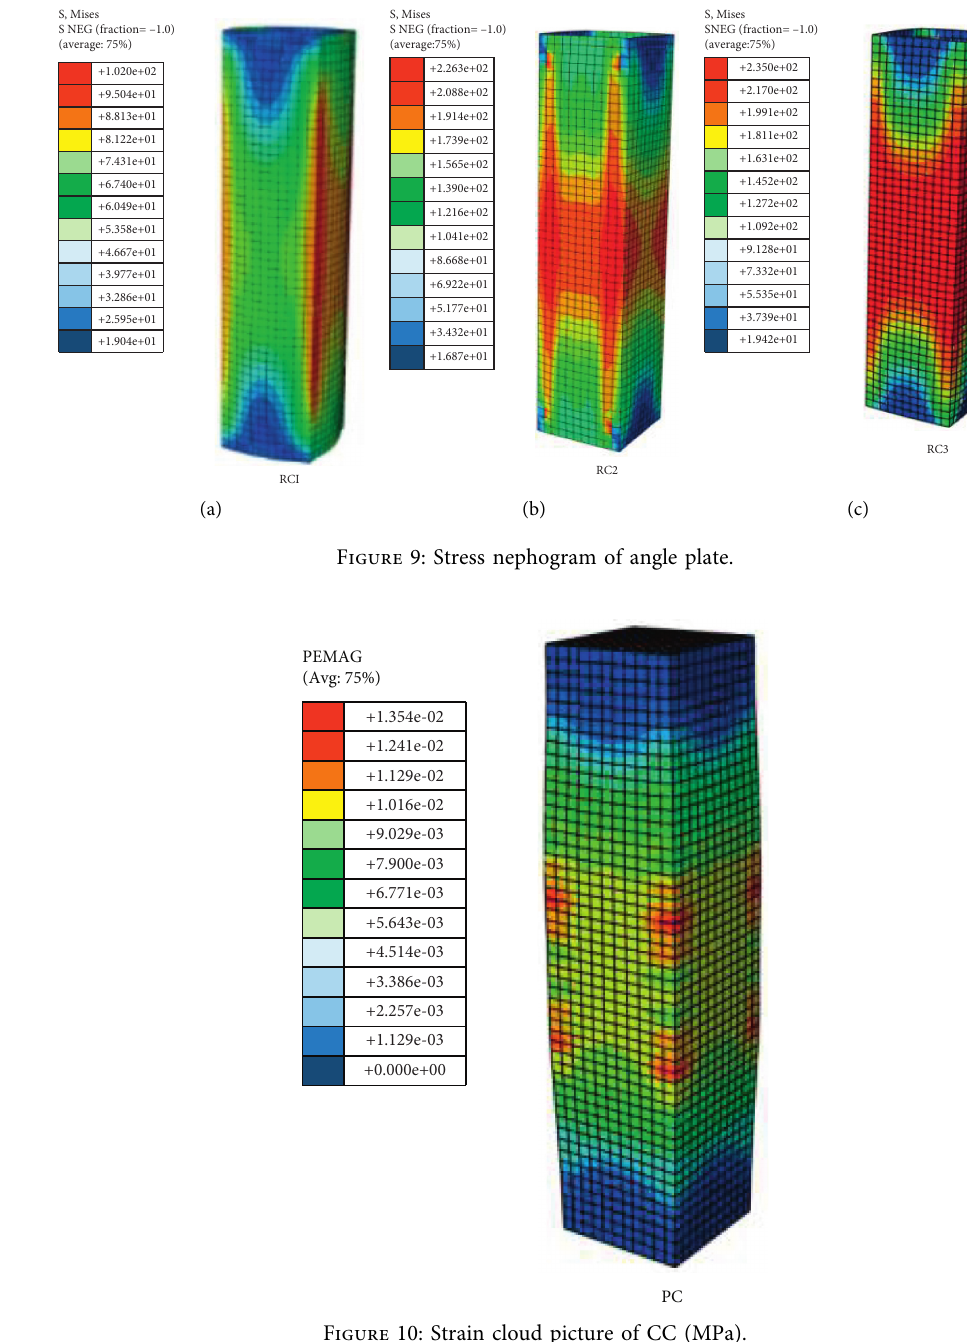
Figure 10: Strain cloud picture of CC (MPa).